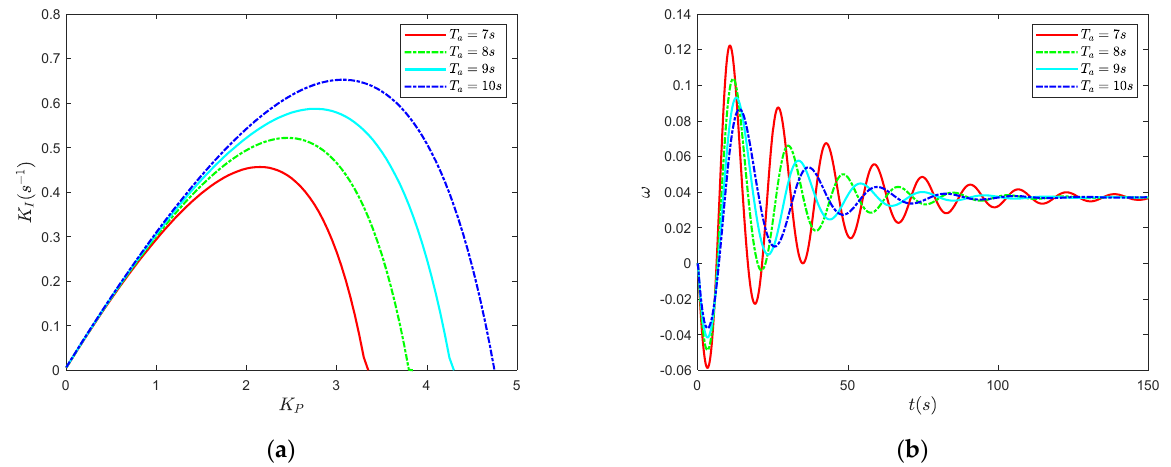
Figure 12. Effect of T a on stability and dynamic characteristics: ( a ) Stable region; ( b ) Dynamic response.